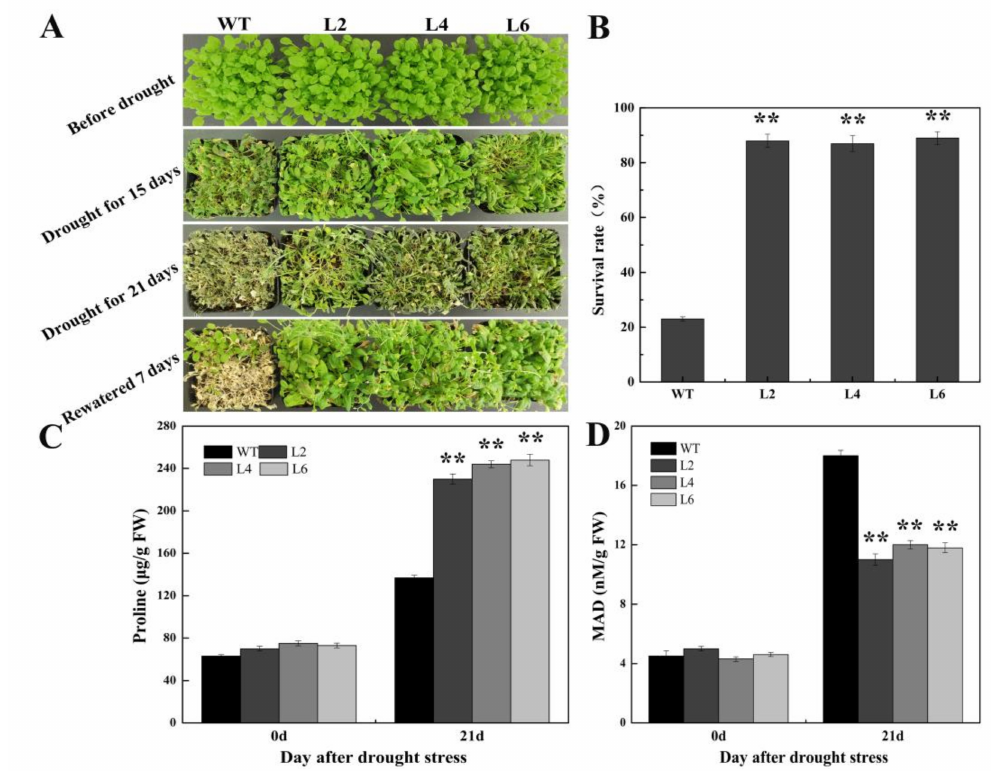
Figure 5. Photographs showing a comparison of the drought resistance state of the transgenic and WT plants. ( A ) E ff ects of drought on the transgenic and WT plants. ( B ) The survival rate of the transgenic and WT plants after being rewatered for 7 days. ( C ) The proline content. ( D ) The MDA content. Error bars represent ± SD, and each value represents the averages of three repeated measurements. ** indicate significant di ff erences between the transgenic plants and the WT plants ( p <